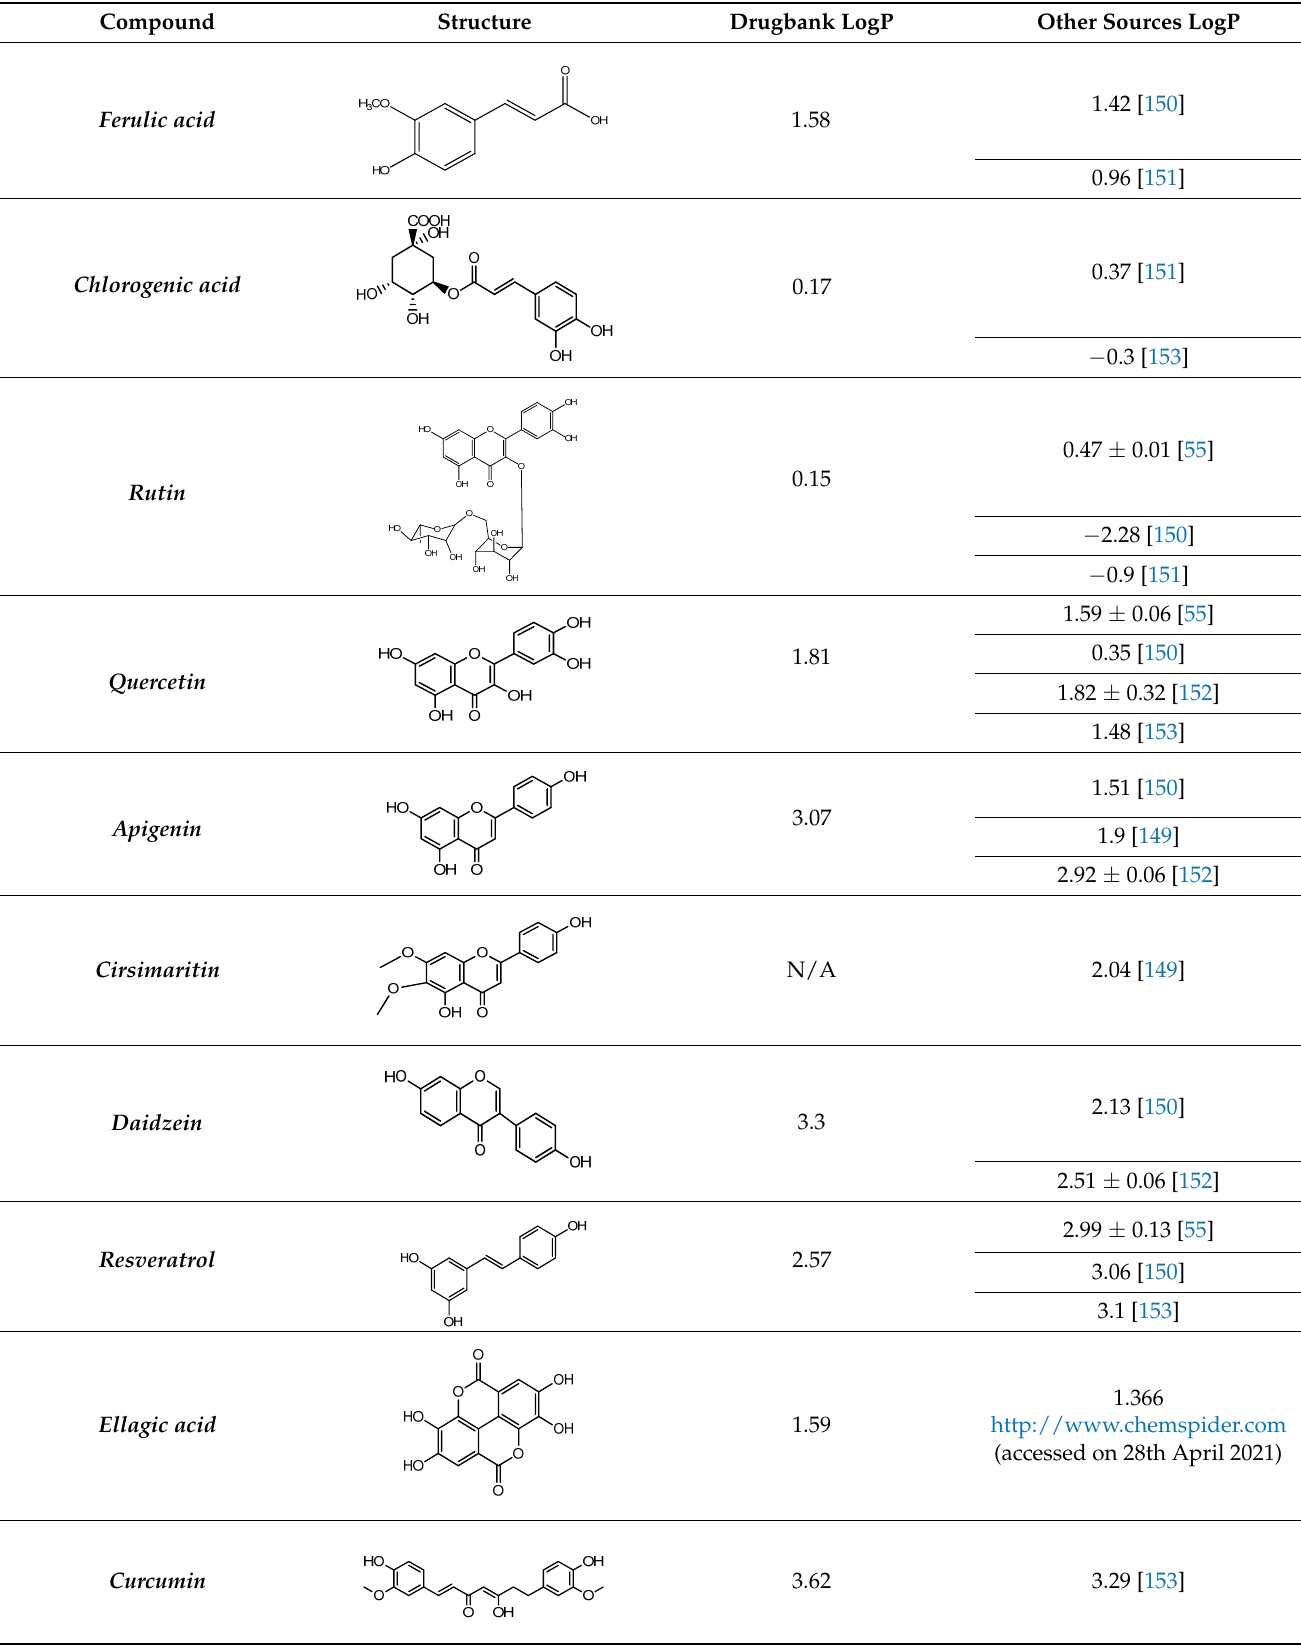
Table 1. Experimental LogP values reported by Drugbank.com database compared with miscellaneous references. Compound